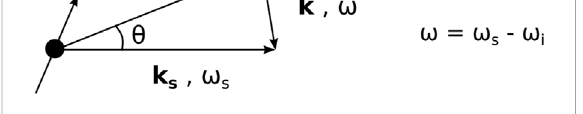
FIGURE 2 De fi nitionoftheobservationwavevector k ,asthevectorsum of the incident ( k i ) and scattering ( k s ) wave vectors. Observation, scattering and incident frequencies are denoted by ω , ω s and ω i , respectively. The black dot depicts an arbitrary electron from which scattering occurs, moving at a velocity v